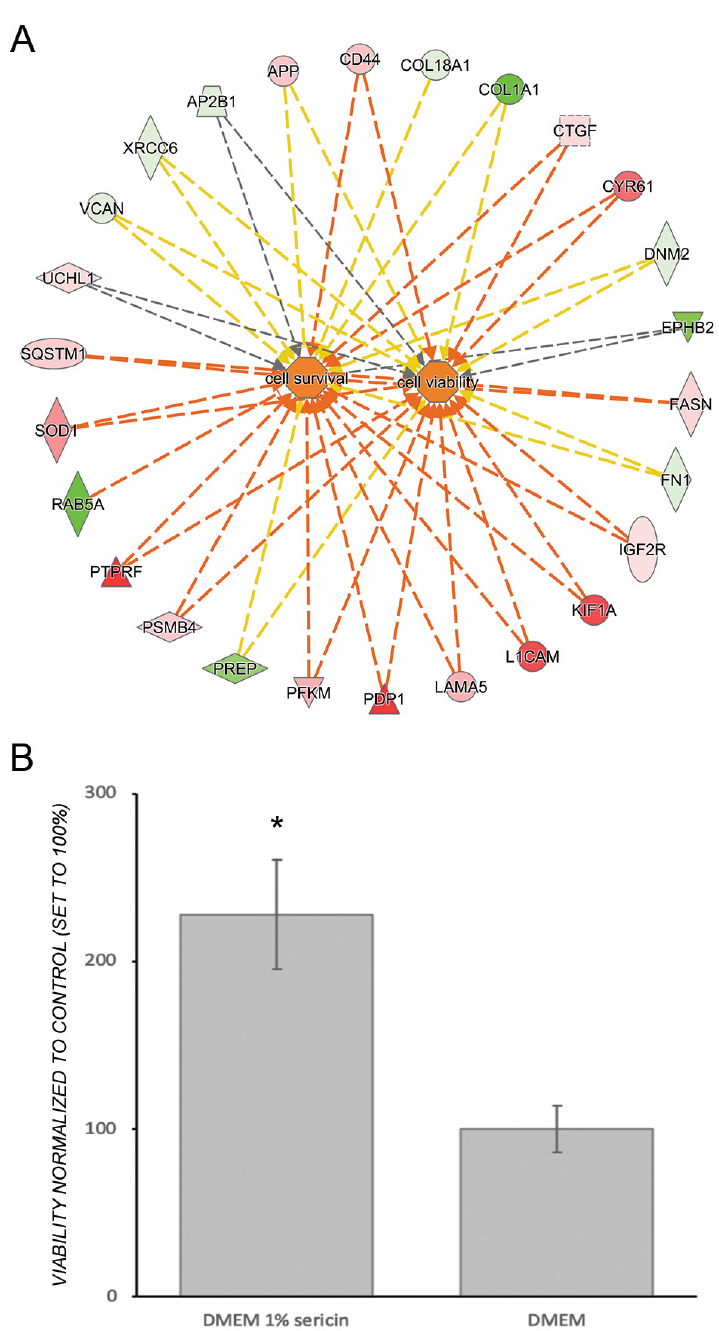
Figure 5. Ingenuity Pathway Analysis (IPA) predicted a downstream effect compatible with increased viability and survival of human fetal retinal pigment epithelial cells (RPE) cultured in in Dulbecco’s Modified Eagle’s Medium (DMEM) with 1% sericin compared to cells cultured without sericin ( A ). Red and pink symbols indicate increased protein levels upon culturing in presence of sericin, while green symbols indicate reduced protein levels. The dotted lines indicate indirect relationships leading to activation (orange). Yellow and grey dotted lines indicate inconsistent relationships and no predicted effects, respectively. To verify the effects on cell survival and viability predicted by IPA, the culture well area of CAM-stained live cells was measured in confluent layers of RPE cultured in DMEM with 1% sericin or DMEM alone. The bar chart ( B ) shows culture well area covered by live cells in RPE cultured in DMEM with 1% sericin normalized to the control cultures, i.e., RPE cultured in DMEM alone (100%). RPE cultured in DMEM with 1% sericin yielded significantly higher cell viability compared to cells cultured without sericin ( p = 0.04). Error bars represent standard deviation of the mean. * p < 0.05. N = 3.